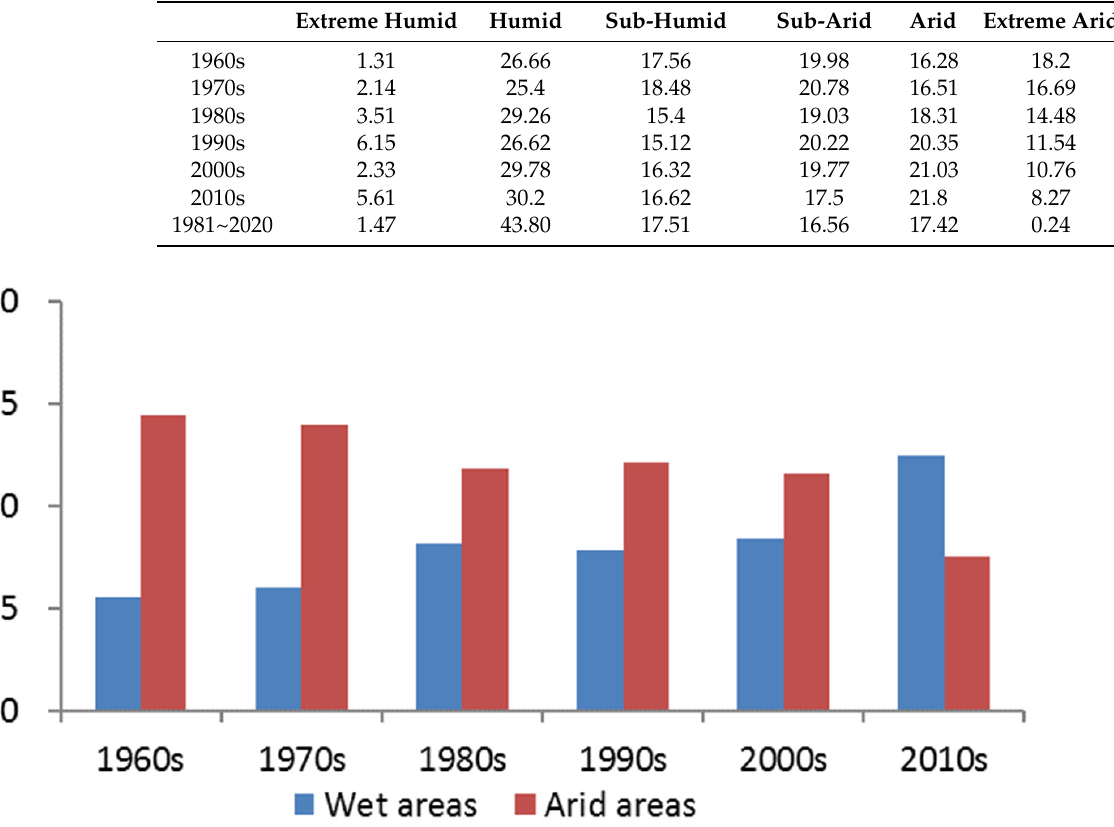
Figure 4. The proportions of the whole dry area and the whole wet area to the area of China in different decades from 1961 to 2020 (unit: %).